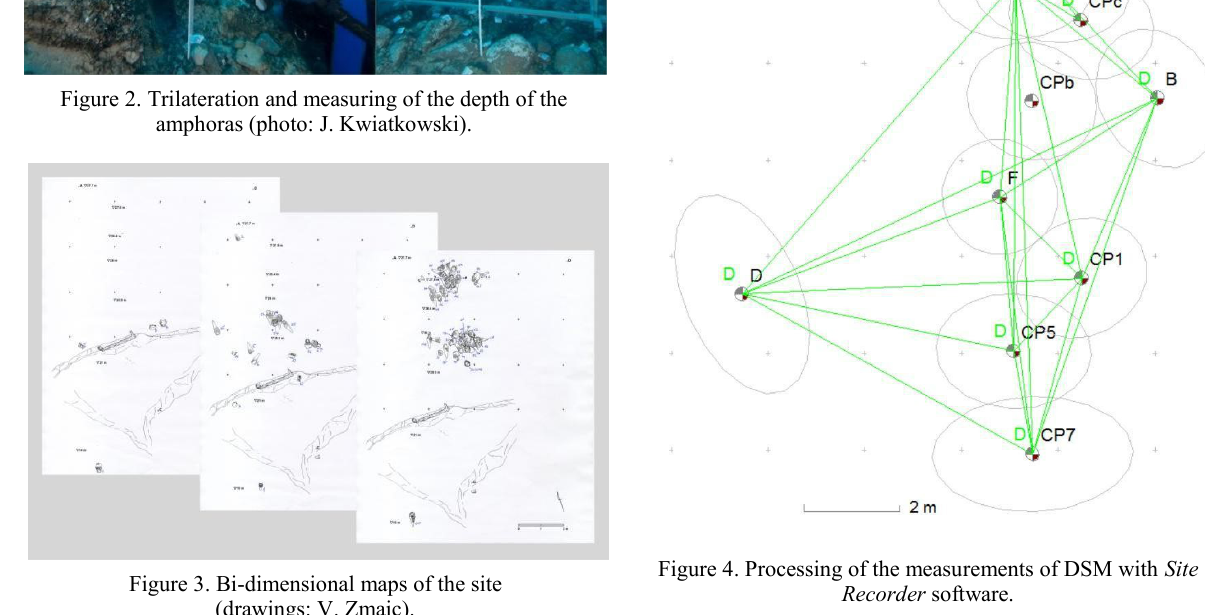
Figure 3. Bi-dimensional maps of the site (drawings: V. Zmaic).